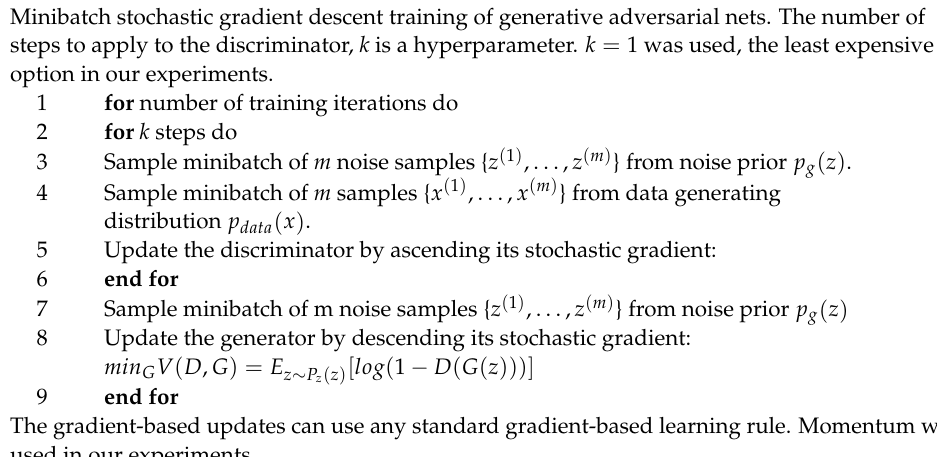
Algorithm 1. Generating adversarial networks pseudocode .